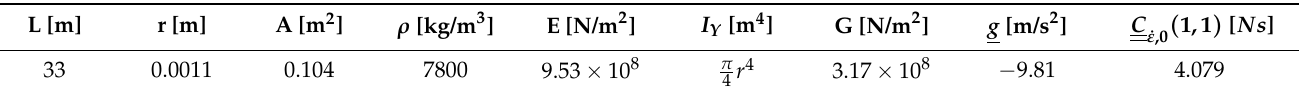
Table 7. Geometrical and material properties of the Catenary chain. The coefficients for the external force calculation were taken from